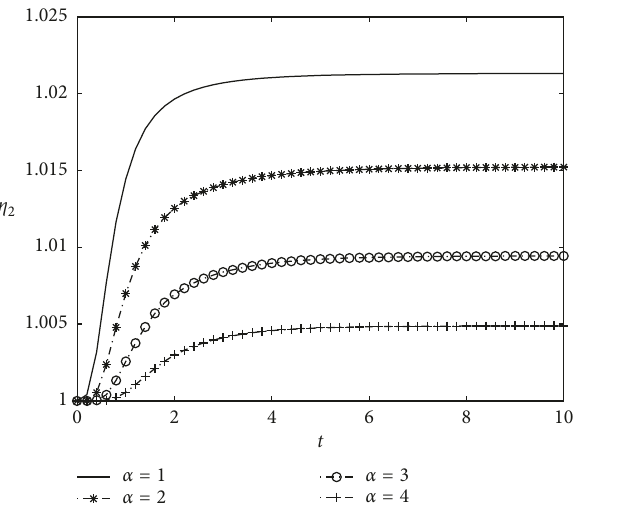
Figure 8: η over time for various values of α when applying the 2 second nonlinear adaptive